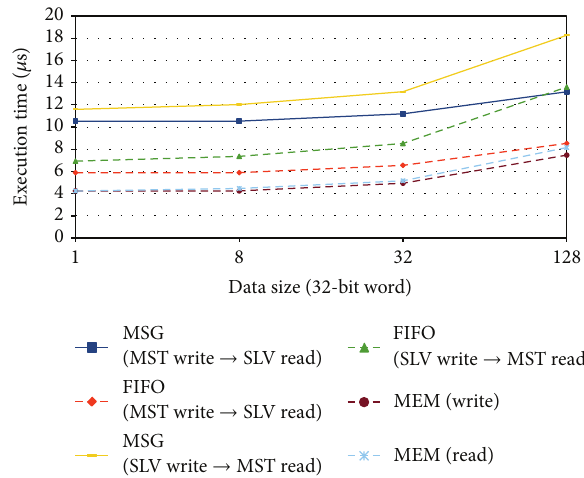
Figure24:HW-HWcommunicationtimesfordifferentsizesofdata (HWT @